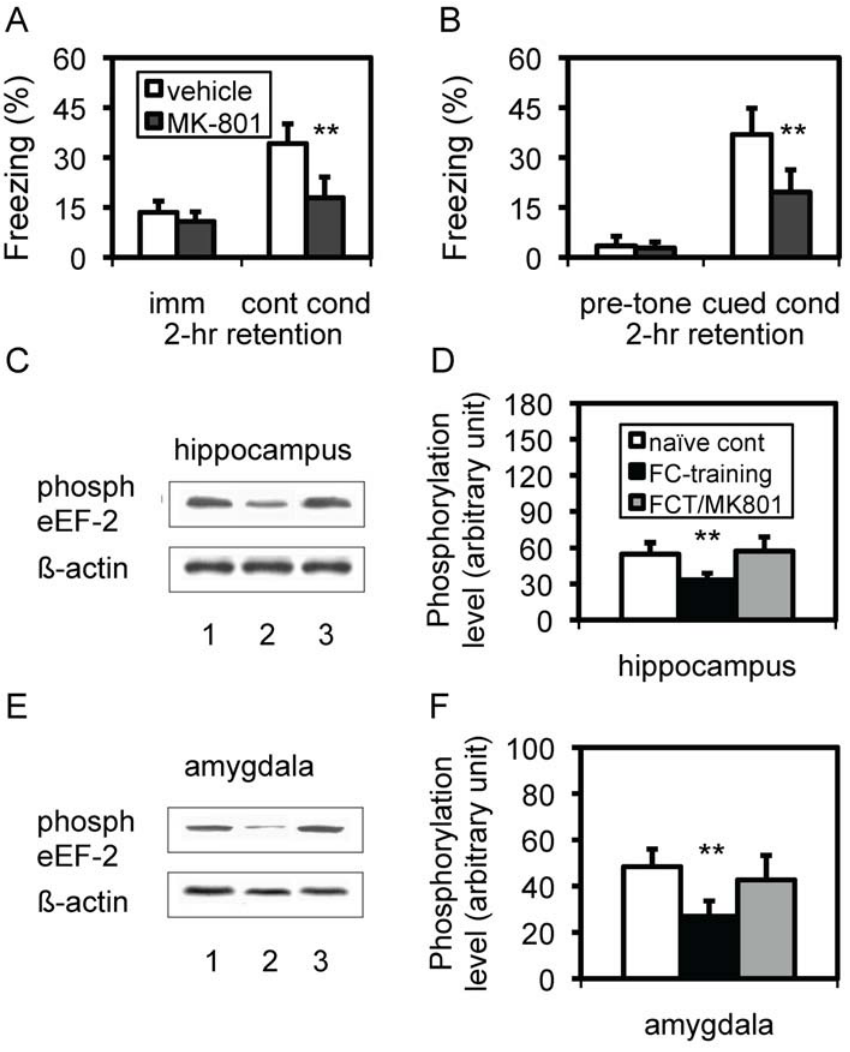
Figure 3. Effect of MK-801 on post-training dephospho-eEF-2 and memory retention. A . Contextual conditioning 2 hr after training/MK-801 treatment. **, p , 0.01,Student’s t test.Imm: immediate freezing;cont cond: contextualconditioning. B . Cued conditioning memory in the same mice. **, p , 0.01, Student’s t test. cued cond: cued conditioning. C . Expression level of phospho-eEF-2 (phosph) in hippocampi from mice 2 hr after training/MK- 801 treatment. 1: naı¨ve control; 2: mice with training/vehicle; 3: mice with training/MK-801. D . Quantitative analysis of the expression of phospho-eEF-2 in hippocampi from mice 2 hr after the training. **, p , 0.01; Student’s t test, compared between trained group-treated with vehicle and either naı¨ve group or trained group-treated with MK-801. E . The expression level of phospho-eEF-2 (phosph) in amygdalae from mice 2 hr after the training.